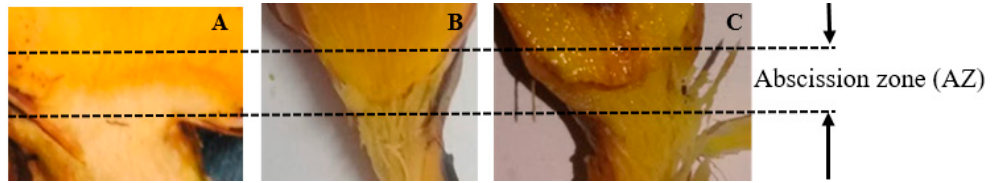
Figure 4. Photograph of a transvers section of the AZ of OPF showing dissolution of the pectin layer ( A —untreated fruit, B —heat-treated fruit at 343 K in water for 60 min, and C —heat-treated fruit in water at 373 K for 60 min).